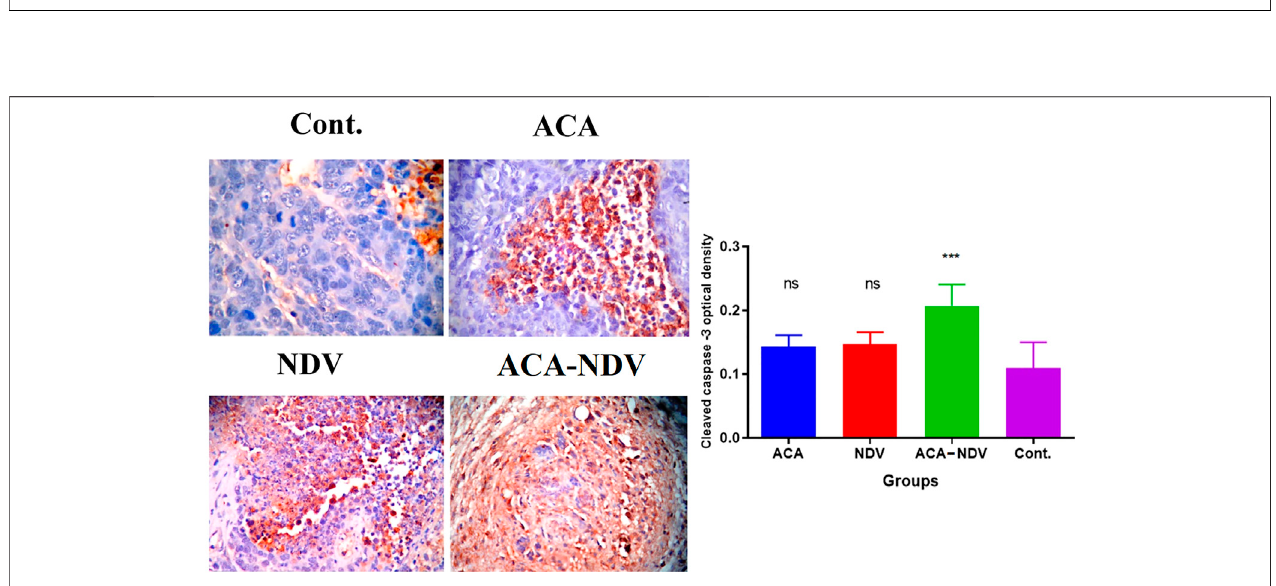
FIGURE4| ACA-NDVcombination therapy induces apoptosis, con fi rmedby immunohistochemistry analysis forcleaved caspase-3. Resultsshowed amild effect on breast cancer cells in monotherapy (ACA and NDV alone)-treated groups, while the combination therapy of ACA-NDV has more cas-3 expression than the single therapy. ppp p < 0.001 versus